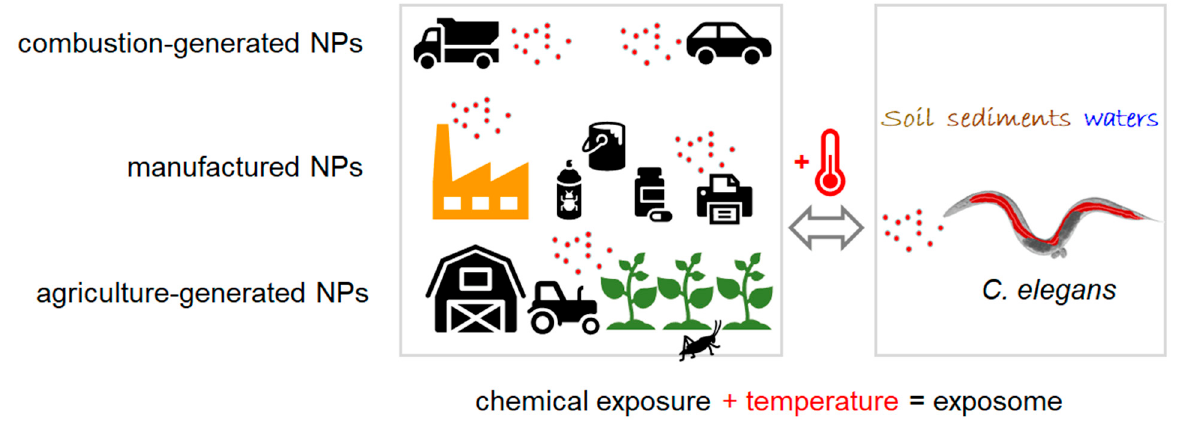
Figure 1. The first encounter of wild C. elegans with different nanomaterials (schematic). Combustion-generated, manufactured and agriculture-generated nanoparticles represent chemical stressors. Nanomaterials flow to the environmental compartments soil, sediments and surface waters. Ambient temperature constitutes an additional non-chemical stressor that adds—together with the chemical exposure—to the exposome. C. elegans , Caenorhabditis elegans ; NPs,